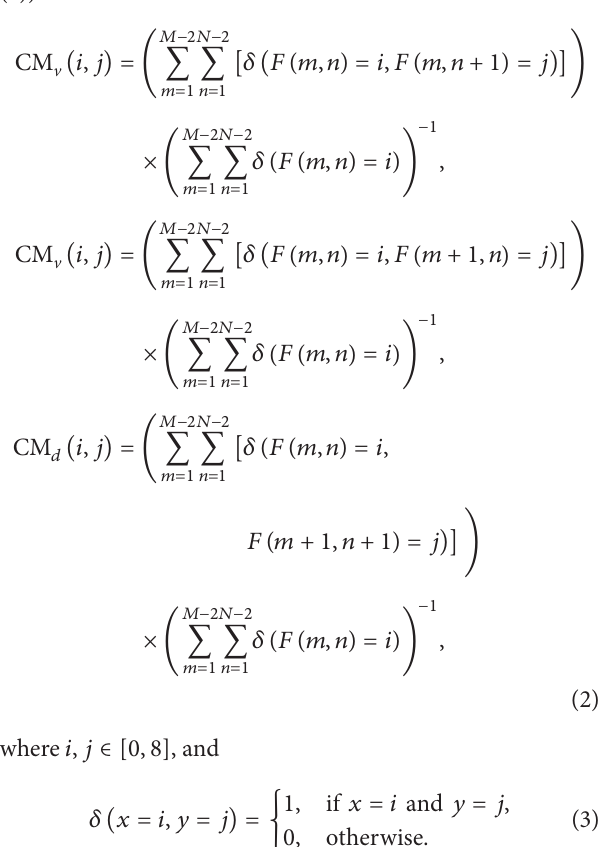
Table 1: Detection results of the first order submodels. Model